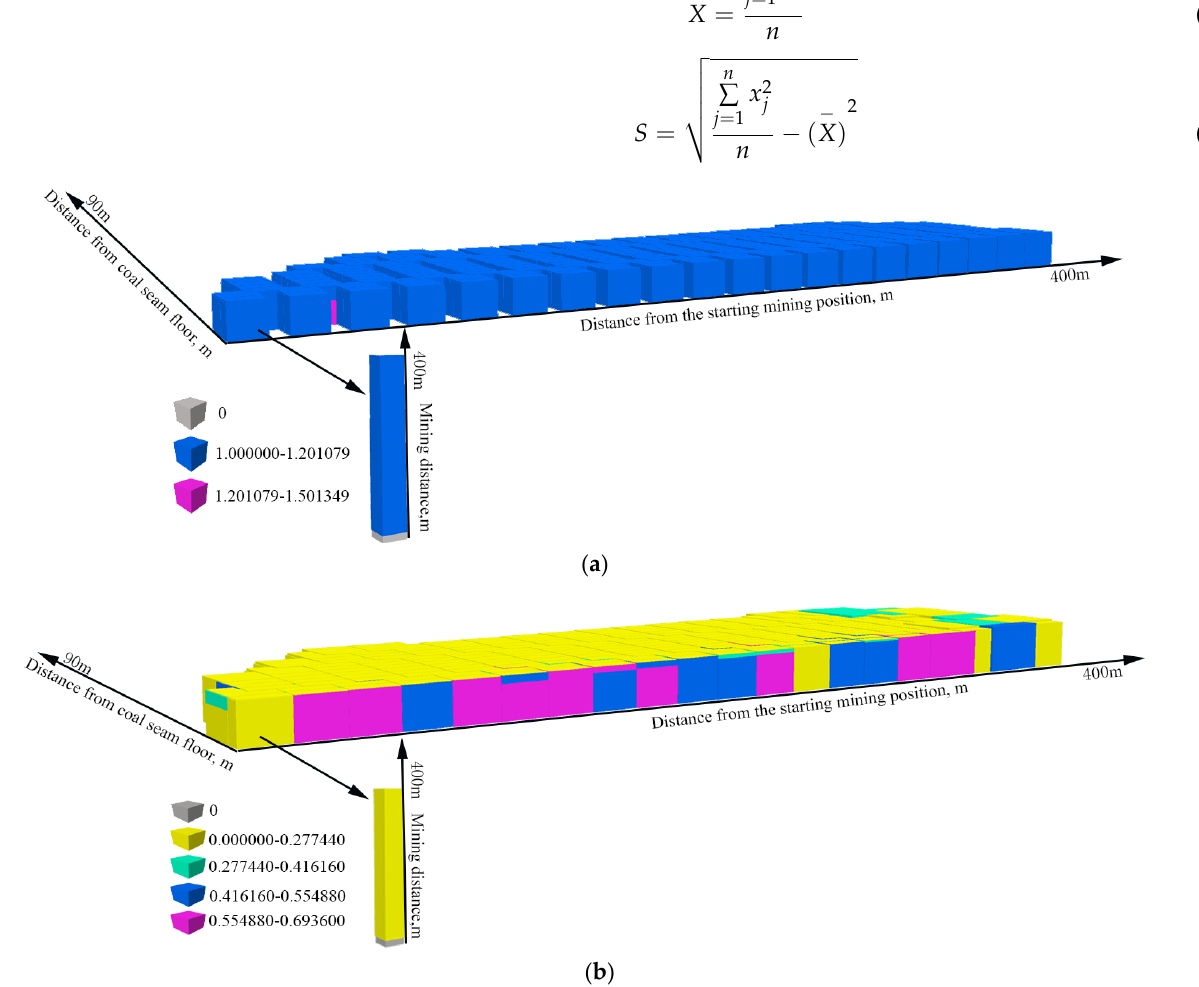
Figure 9. Space – time cube of fracture entropy in mining-induced rock mass fractures: ( a ) fractal dimension; ( b ) fracture entropy.